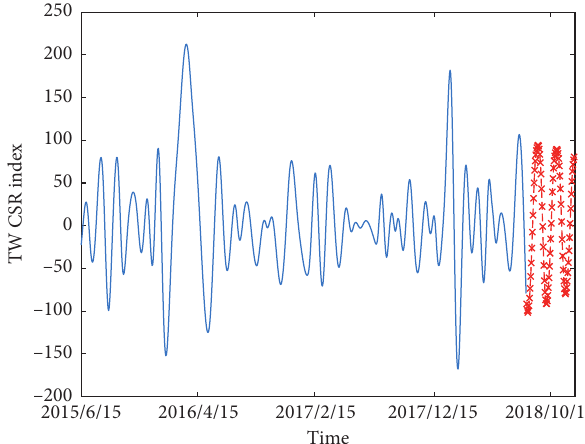
Figure 12: LSTM prediction results for IMF3.